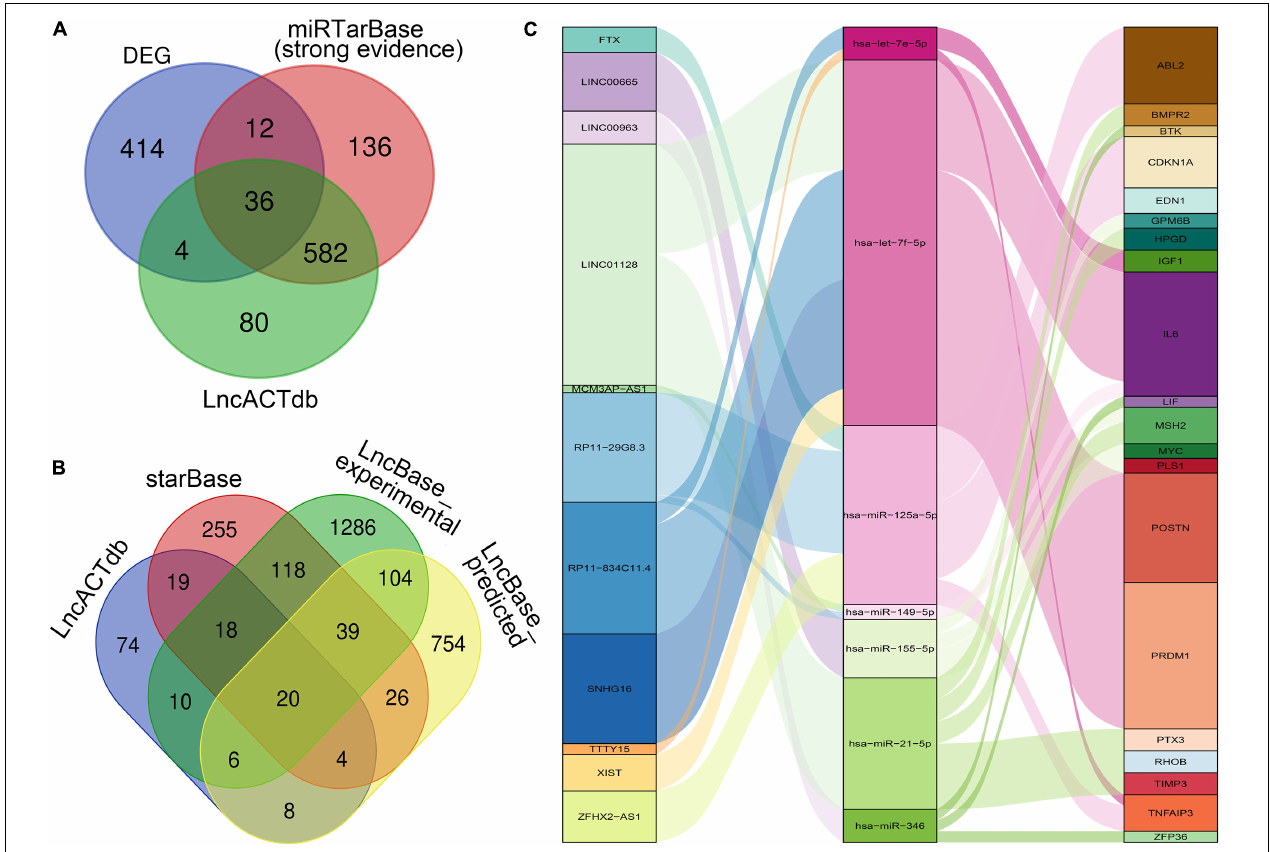
FIGURE 3 | Construction of the ceRNA Co-expression network. (A) Venn plot: The intersection of DEGs, predicted mRNAs by miRTarBase, and predicted mRNAs by LncACTdb. (B) Venn plot: Overlapped lncRNAs predicted by starBase, LncBase_predicted, LncBase_experimental, and LncACTdb. (C) The lncRNA–miRNA–mRNA ceRNA Sankey plot was constructed via 11 lncRNAs, 7 miRNAs, and 20 mRNAs for SSc-ILD.